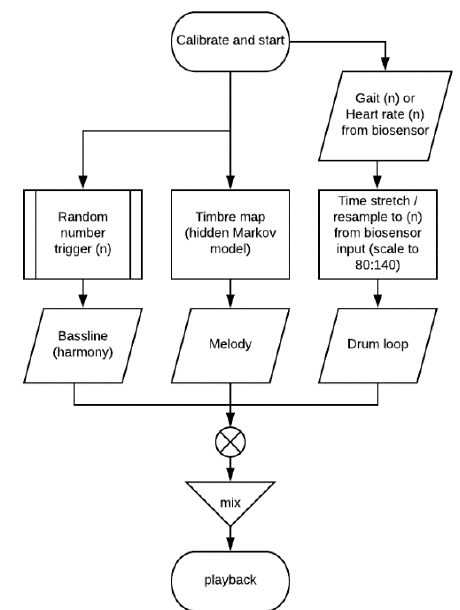
Figure 1. Overview of music generation system. Tempo, melody, and timbral features in the generated music output are modulated according to biosensor input from individual users. Timbre mapping is by 2nd order hidden markov model.